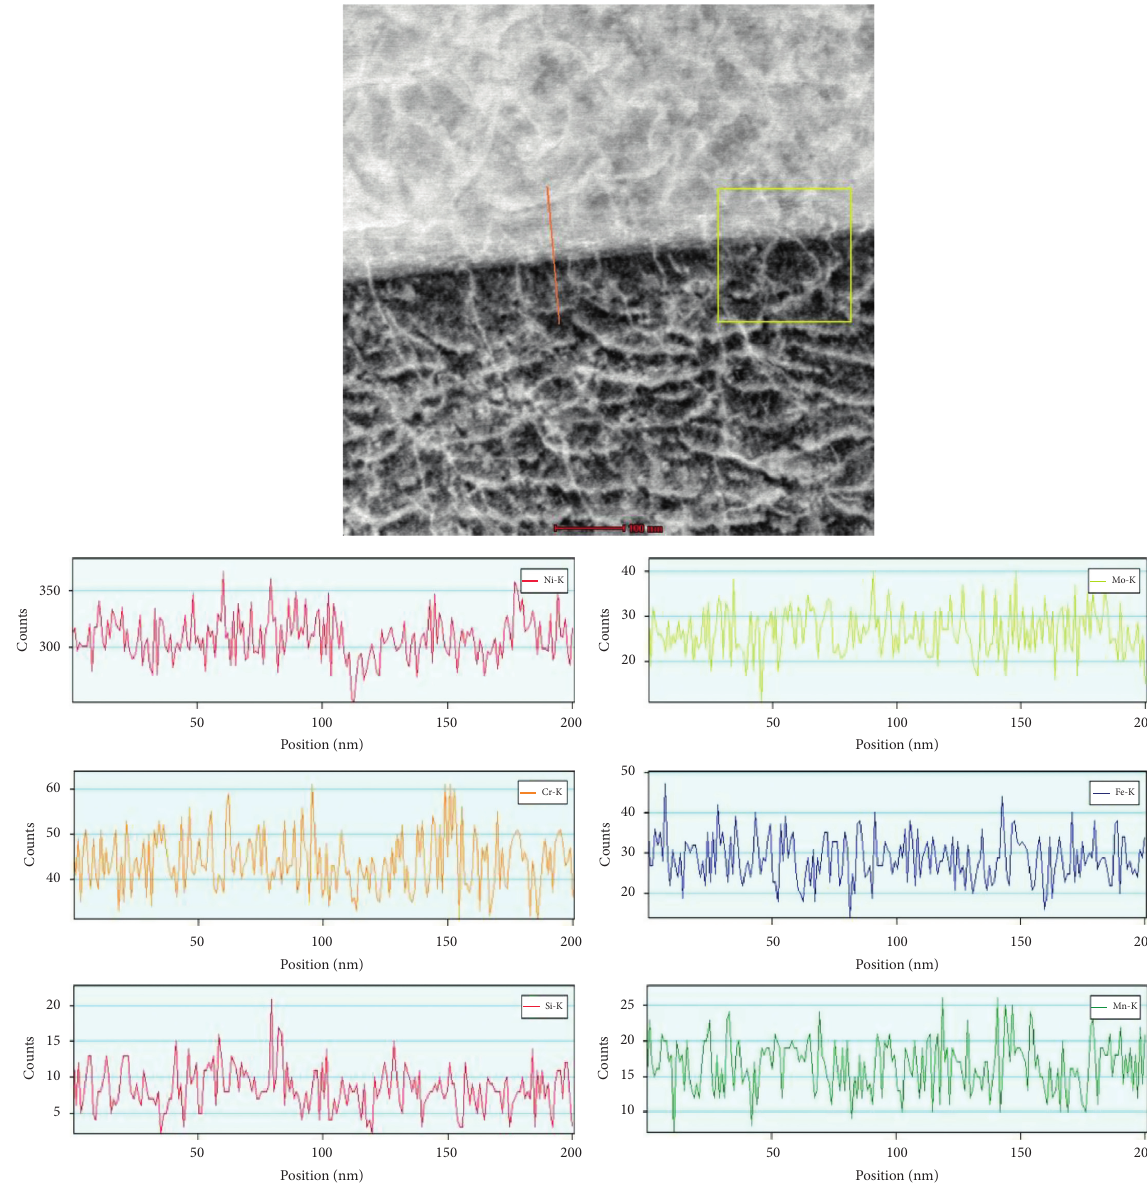
Figure 6: Distribution of elements near the grain boundary of Hastelloy N after irradiation